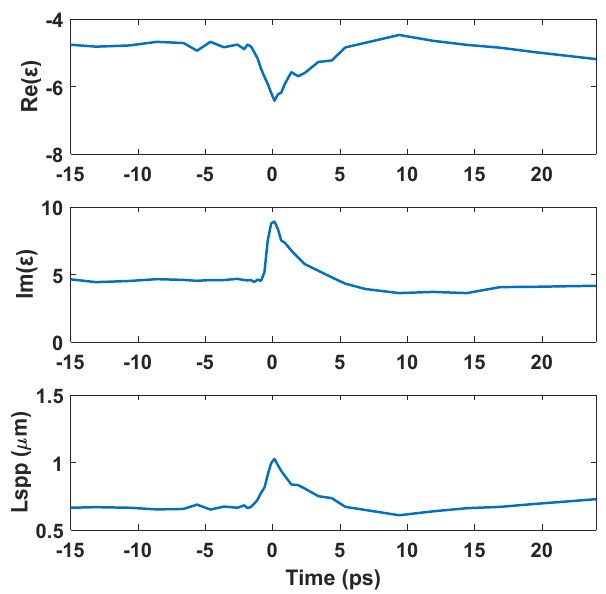
Figure 5. Dynamic permittivity ε and Lspp.